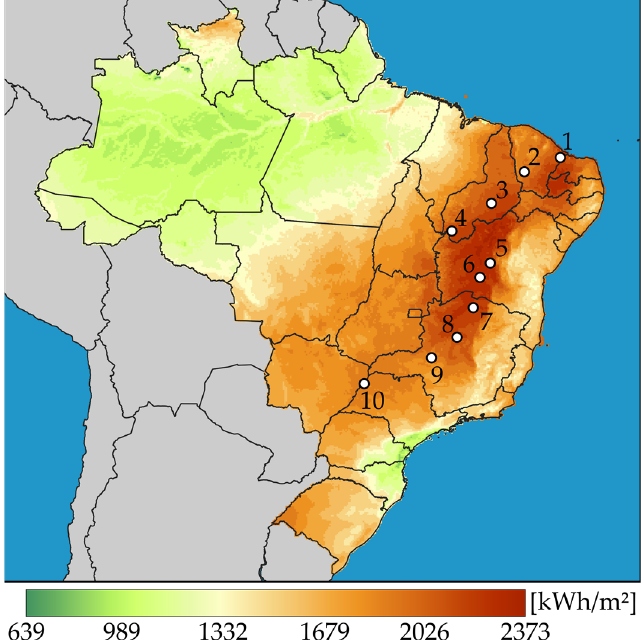
Figure 1. Annual average DNI map indicating the selected locations. The details of the locations can be seen in Table 2 according to its id. number (from 1 to 10). Table 2. Localization and overall average of weather characteristics of the studied cities.